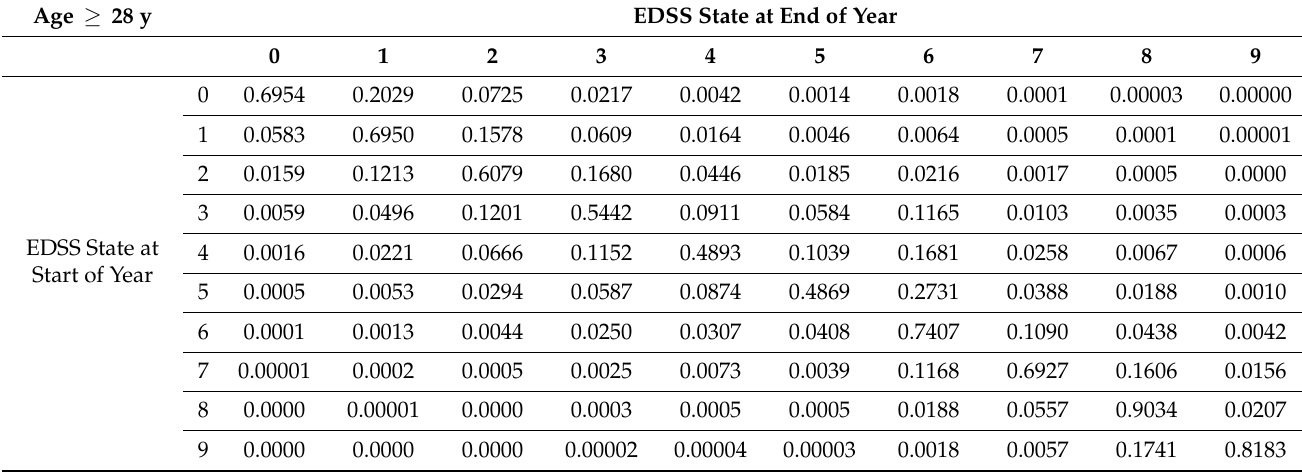
Table A2. Transition Probability Matrix for 10-State Disability (EDSS) in the British Columbia Multiple Sclerosis Dataset.